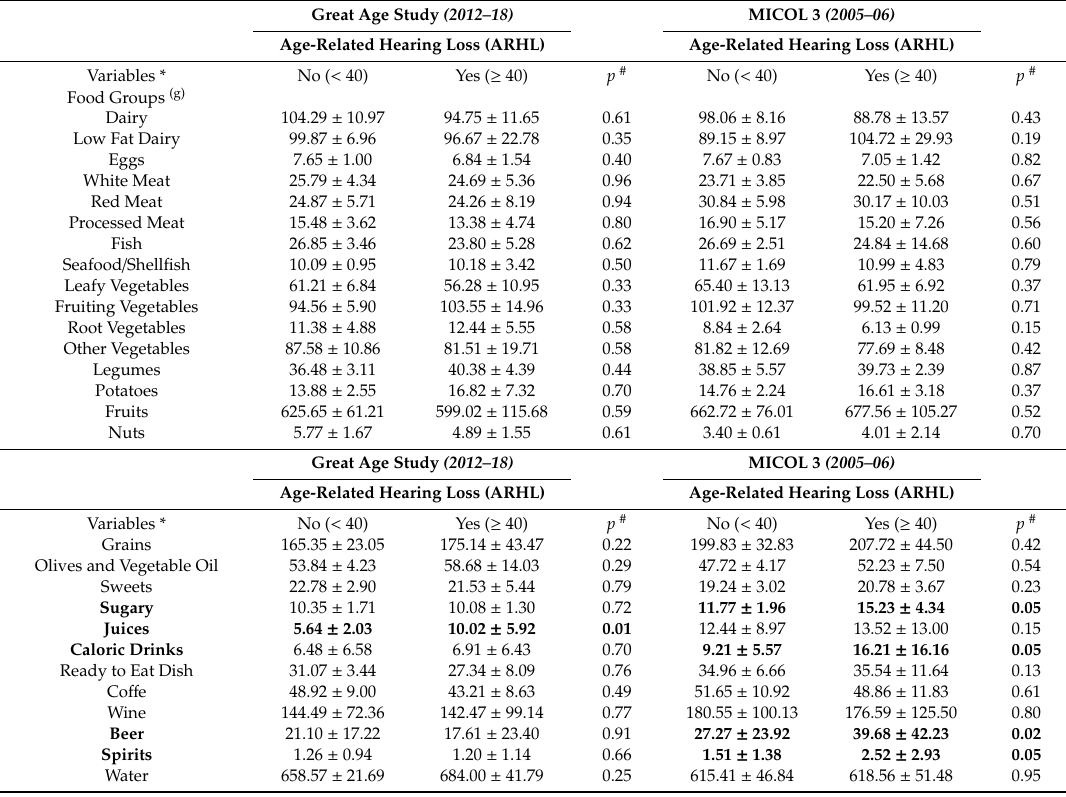
Table 2. Dietary characteristics of the population at baseline (M3) and follow-up (GreatAGE Study, M4) ( n = 734).